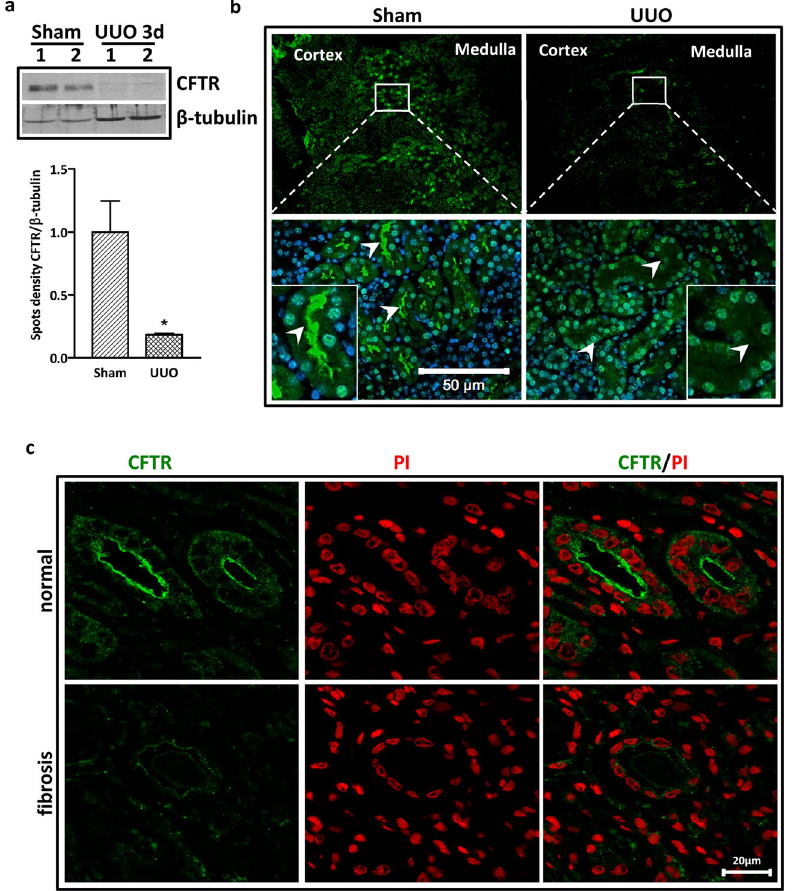
Figure 1. Downregulation of CFTR in UUO mouse model and human fibrotic kidneys. ( a ) Representative western blot showing significantly reduced CFTR expression in UUO kidneys (n = 4) compared to wild type kidneys (n = 5) after 3 days of ligation, quantification is shown in the lower panel, * p < 0.05; (Full-length blot is shown in Supplementary Figure S7a.) ( b ) Immunofluorescent staining showing significantly downregulated CFTR protein in the UUO kidneys compared to the wild type kidneys. Note that in normal kidney, CFTR is expressed in the apical membrane of proximal tubule cells at the corticomedullary junction (white arrow), whereas in UUO kidney, CFTR expression is dramatically downregulated and diffusely localized in the cytoplasm (white arrow), scale bar = 50 µ m; ( c ) Immunofluorescent staining shows that CFTR protein is expressed at cell-cell adhesion and cytoplasm in tubular epithelium in normal human kidney. However, the expression of CFTR is significantly decreased in fibrotic kidney tissue (n = 2), scale bar = 20 µ m. PI: Propidium